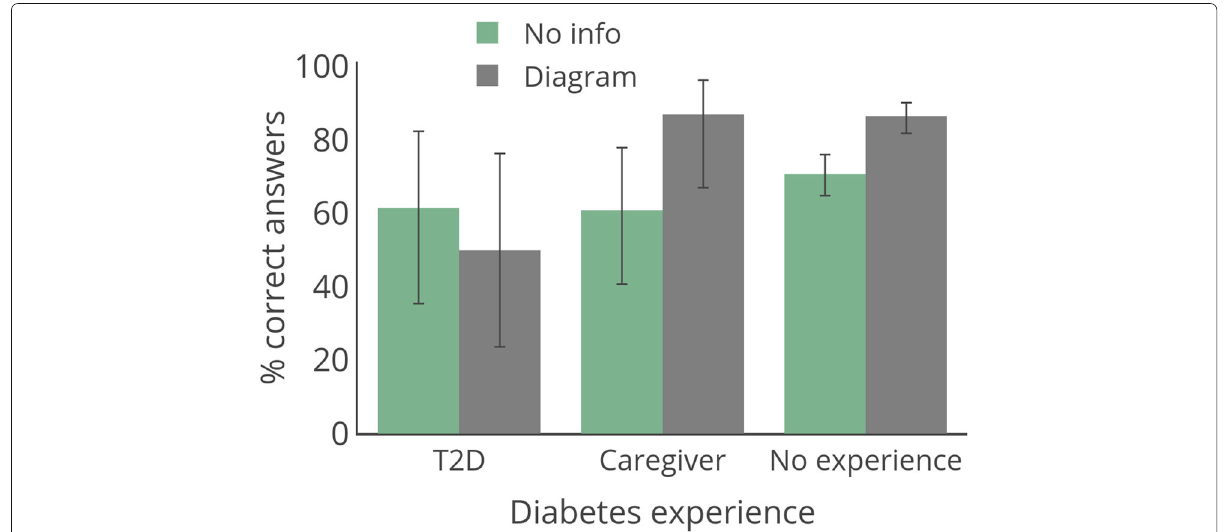
Fig. 4 Results for Experiment 2. Error bars show 95% confidence interval